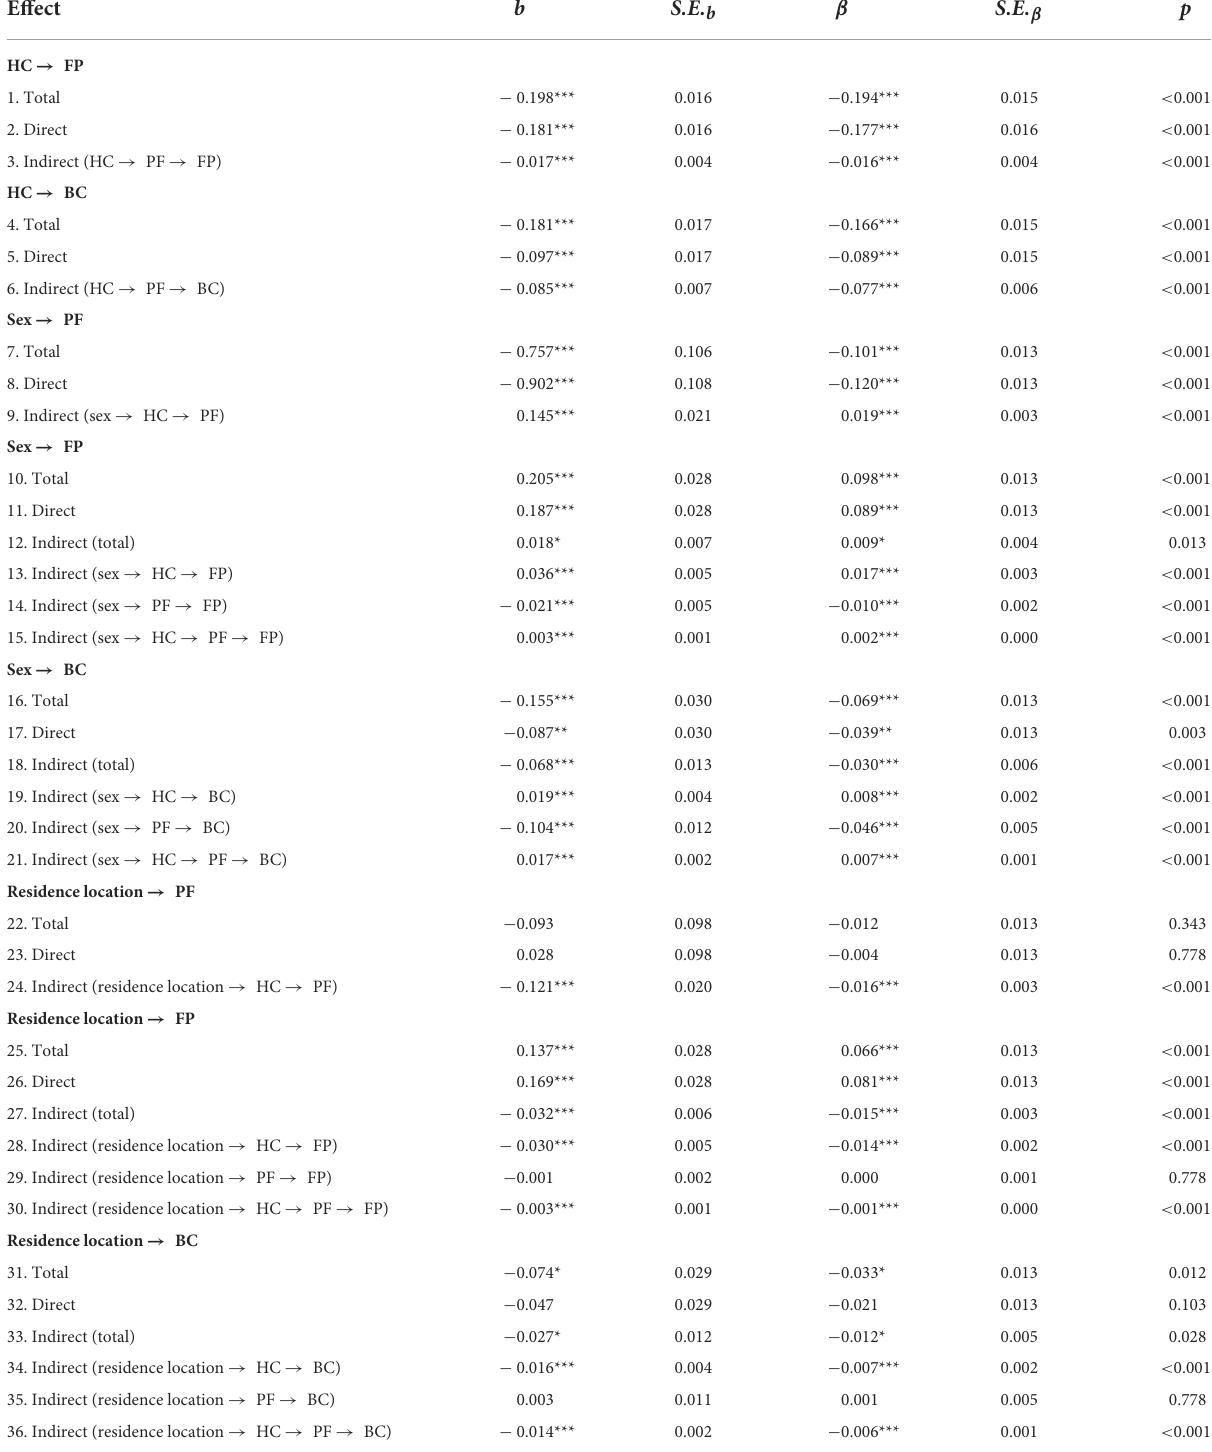
TABLE 5 Direct, indirect, and total effects of life prior to death on quality of death.